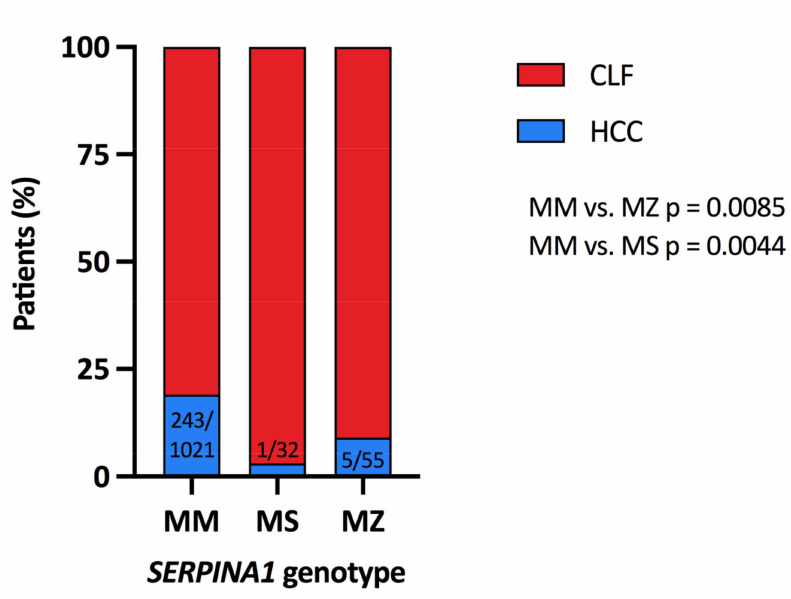
Figure 1. HCC in patients with liver cirrhosis according to the SERPINA1 genotype. HCC, hepatocel- lular carcinoma; CLF, chronic liver